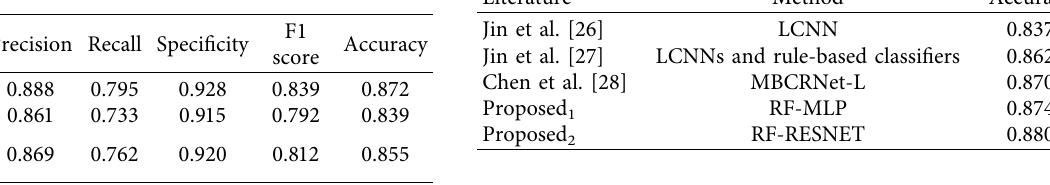
Table 1: Classification results for random forest, MLP, and modified RESNET.